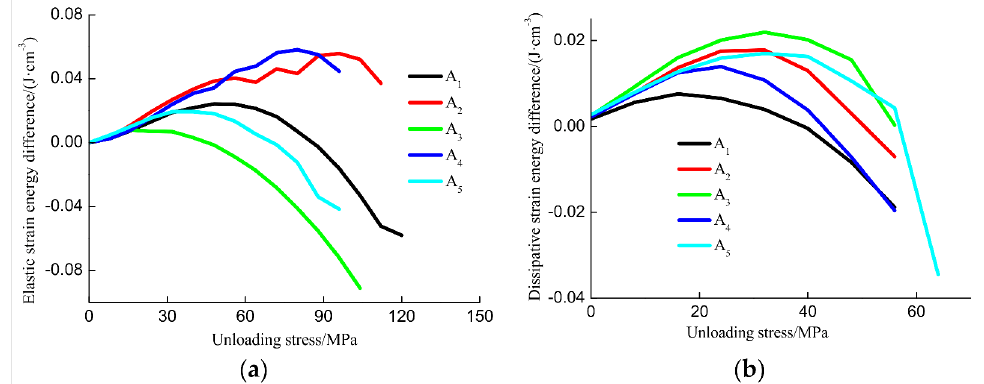
Figure 11. Strain energy difference of dry rock samples. ( a ) Elastic strain energy difference. ( b ) Dissipative strain energy difference.